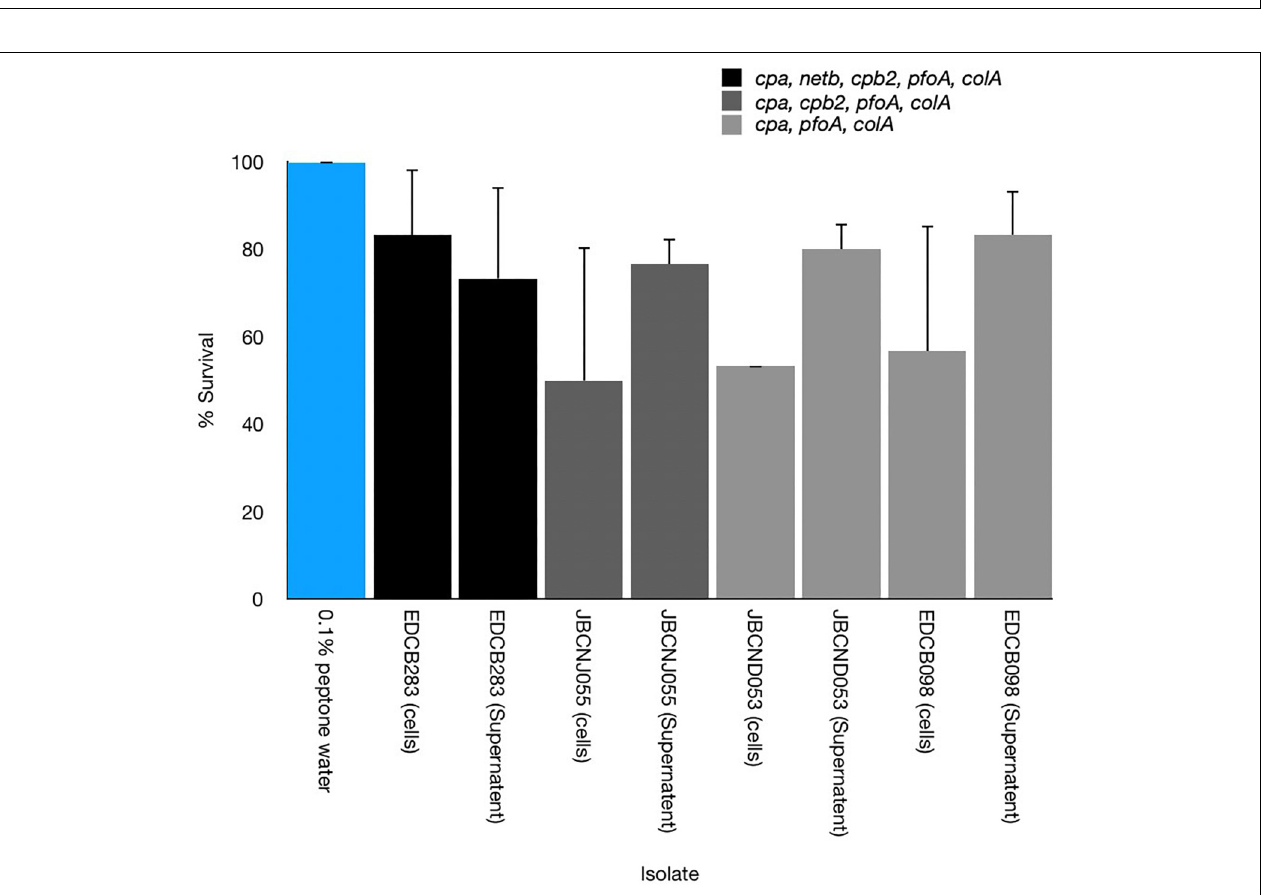
FIGURE 6 | Comparison of the pathogenicity of cell-free supernatants and washed cultures toward G. mellonella of three distinct C. perfringens isolates with differing virulence gene composition. Cell-free supernatants were able to cause disease but with varying degrees of potency. Error bars represent standard deviation.